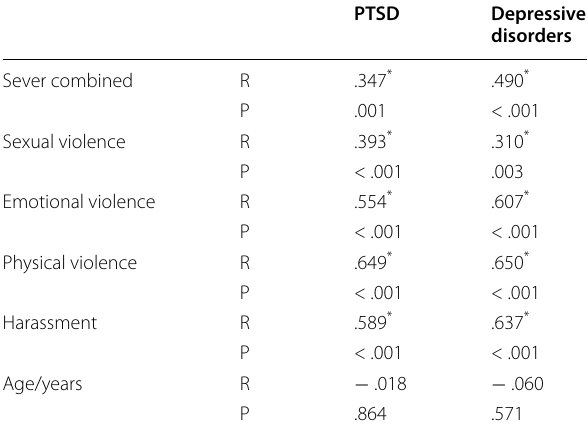
r Spearman correlation